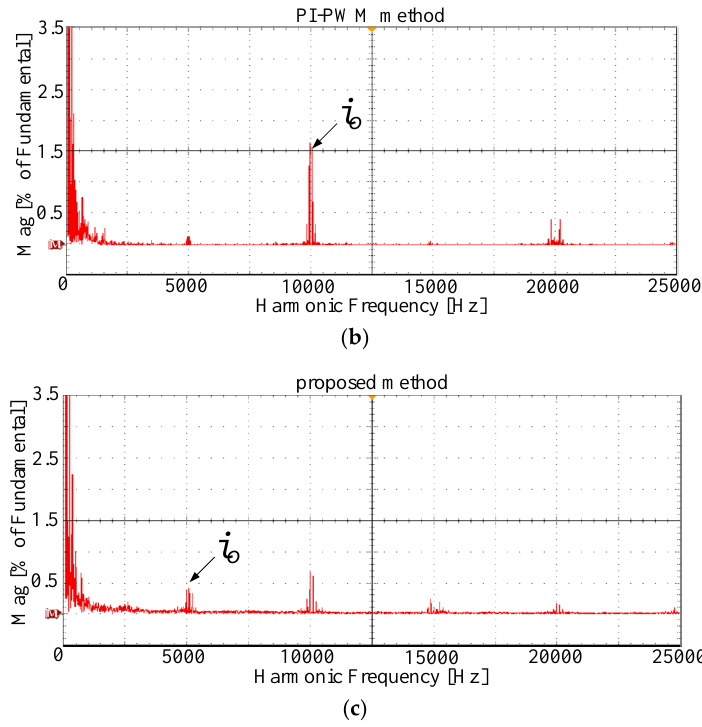
Figure 14. Experimental results of the FFT analysis of the output current ( i o ). ( a ) conv-MPC method ( T s = 33 μs); ( b ) PI-PWM method ( T sw = 200 μs); ( c ) proposed method ( T s = 200 μs). Figure 15 represents the experimental results of transient responses with magnitude and frequency step changes. The output current wave forms of the three methods track the reference changes, which are the same as the simulation results. From Figure 15, it can be seen that the dynamic response of the proposed method is as fast as the conv-MPC method. In fact, the proposed method yields a faster response than the PI-PWM method during the transient period, as shown in Figure 15b,c. Therefore, the proposed method can generate switching patterns with a constant switching frequency similar to the PI-PWM method during steady state, which facilitates the resolution of filter design issues. In addition, the proposed method can maintain dynamics as fast as those of the conv- MPC method, which is faster than the PI-PWM method.